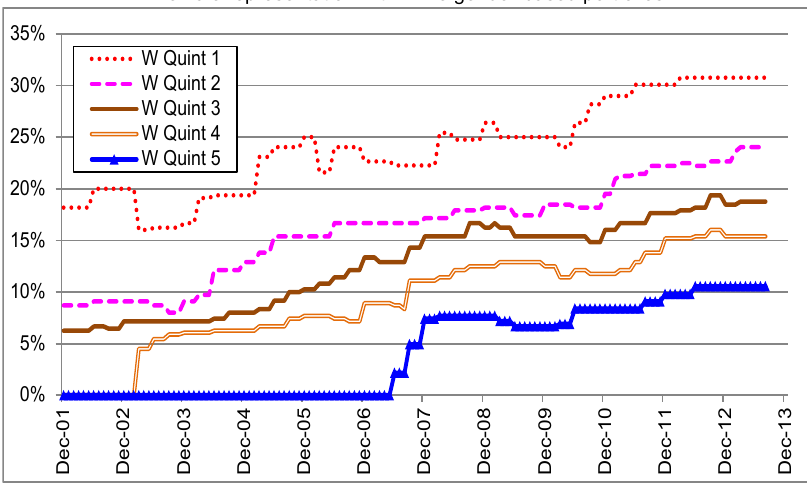
Female representation within five gender-based